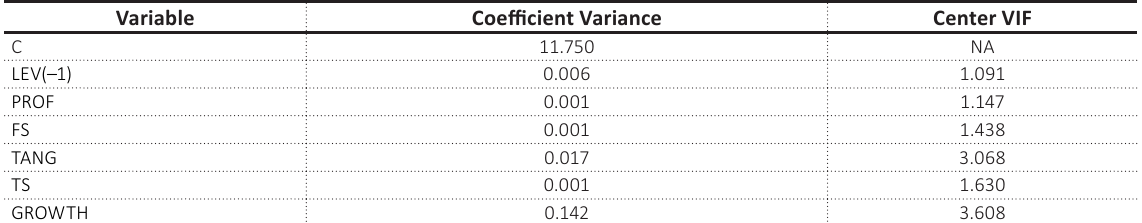
Table A3. Variance Inflation Factor (VIF) test